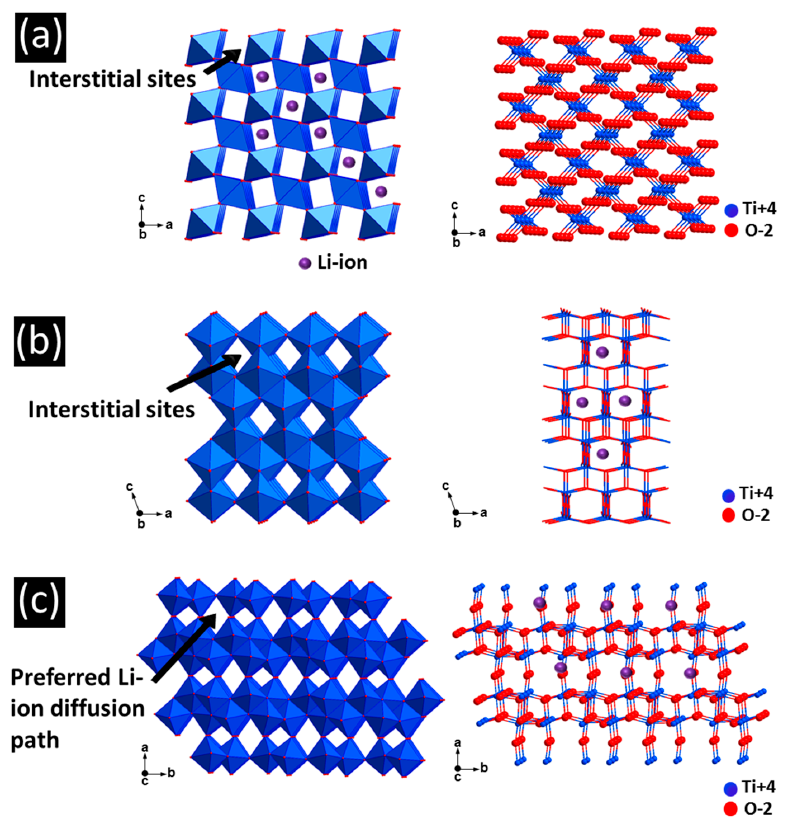
Figure 3. Structure of ( a ) rutile, ( b ) anatase and ( c ) TiO 2 -B. The arrows point to the interstitial sites that can host lithium ions.